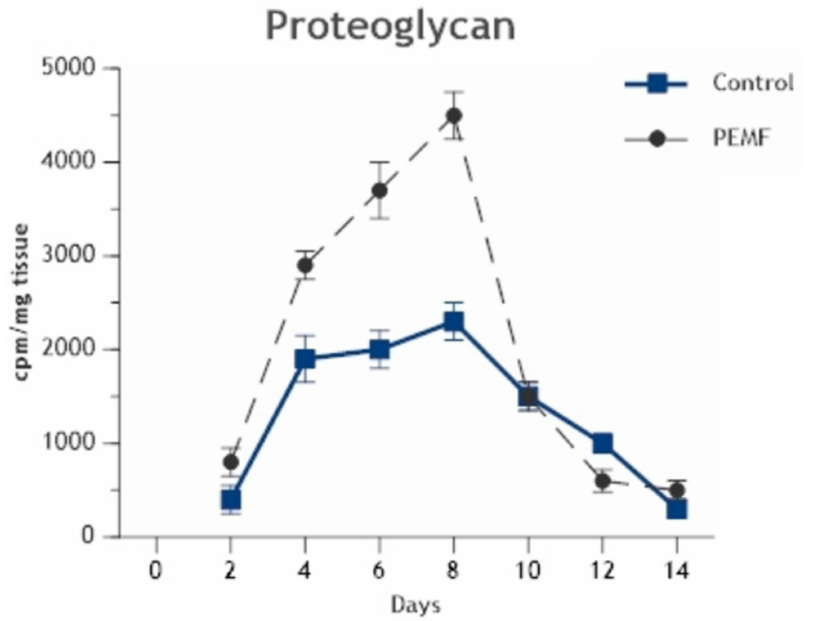
Figure 8. Stimulation of chondrogenesis in endochondral bone formation by PEMFs. Peak of chondrogenesis occurs on day 8 of development in both exposed and unexposed ossicles, with significant increase in aggrecan content in PEMF-exposed ossicles. However, in both exposed and unexposed ossicles, proteoglycan content rapidly decreases with the onset of calcification. With PEMF stimulation, there is no disorganization of temporal sequences of chondrogenesis. Adapted with permission from Ref. [11]. 2006, Annals of the New York Academy of Sciences .